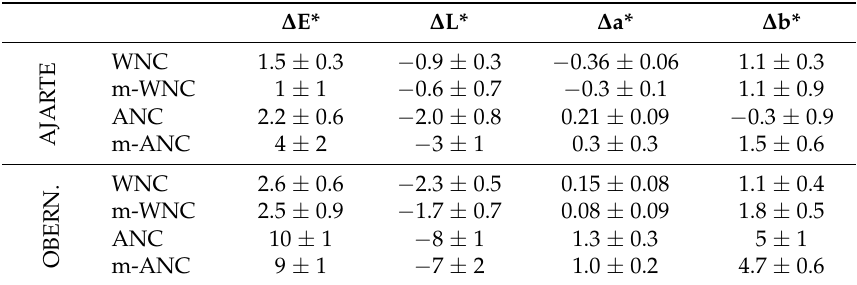
Table 5. Values of ∆ E*, ∆ L*, ∆ a* and ∆ b* of Ajarte and Obernkirchen stones treated with WNC, ANC and their matrices. Values are averaged on 3